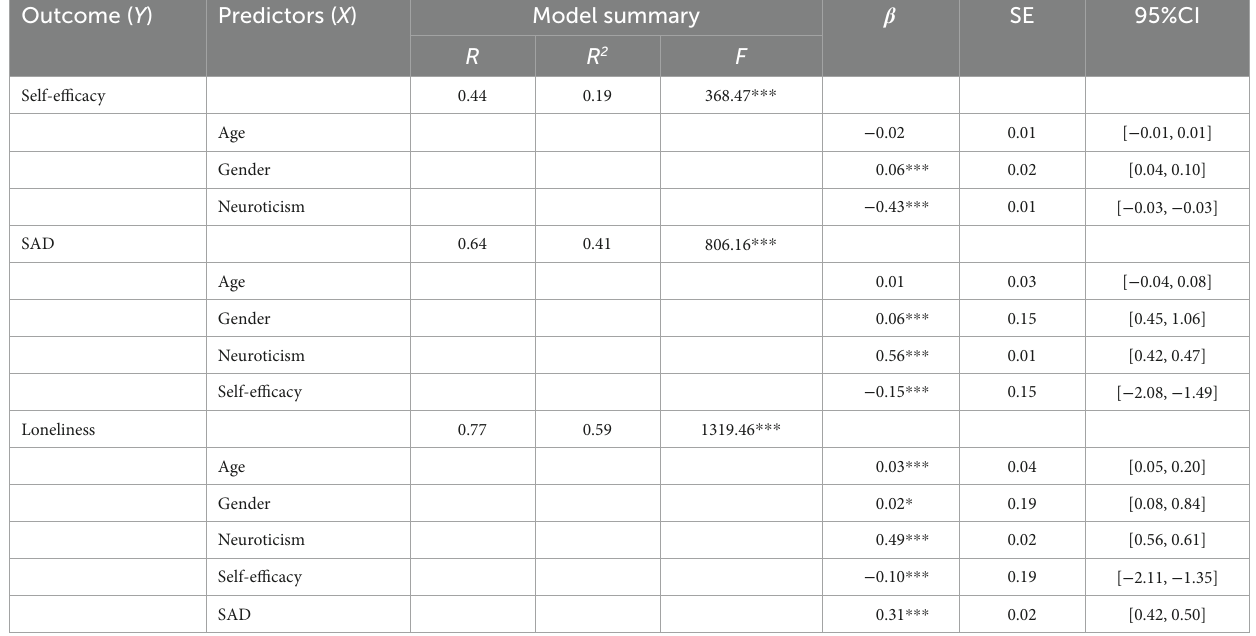
TABLE 4 Regression analysis of mediating models of self-efficacy and SAD between neuroticism and loneliness. Outcome ( Y )